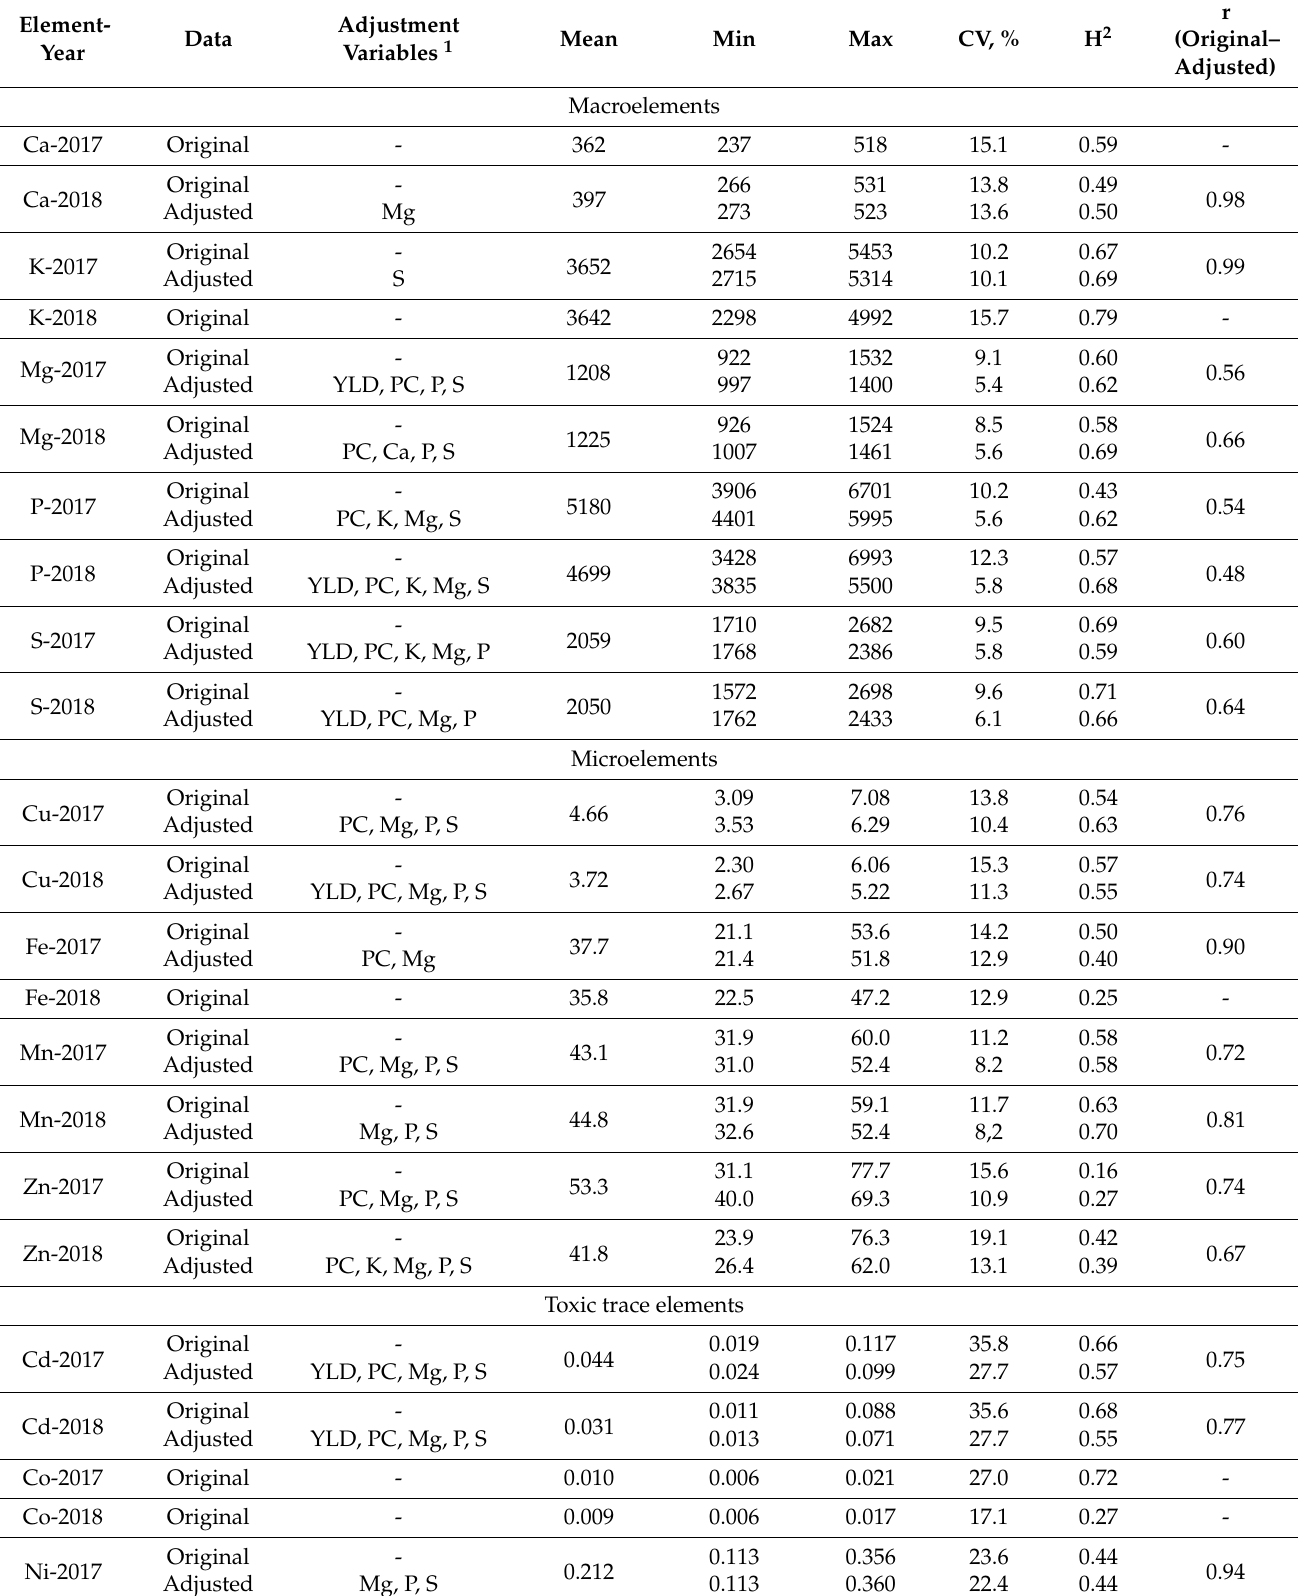
Table 2. Statistical parameters for original and adjusted values across all germplasm in